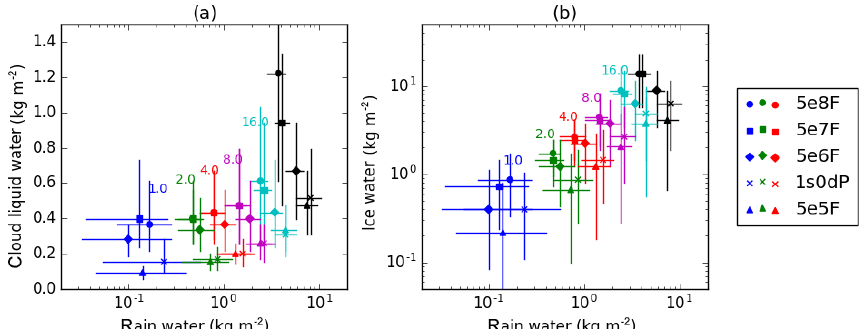
Figure 5. The scaling of (a) cloud-droplet liquid-water path, (b) ice-water path (snow and ice crystals), with rainwater path, partitioned according to the surface-rainfall rate. The different symbols (circles, squares, etc.) denote different model experiments, according to the key shown on the right. The colours corresponded to logarithmically spaced surface-rainfall intervals; the upper bound of each interval is indicated by the coloured text on the plots (e.g, the red-coloured points correspond to grid points where the rain rate was between 2 and 4mmh − 1 ). The black points are for all rain rates greater that 16mmh − 1 . The horizontal and vertical bars show the interquartile ranges in each interval for the ordinate and coordinate